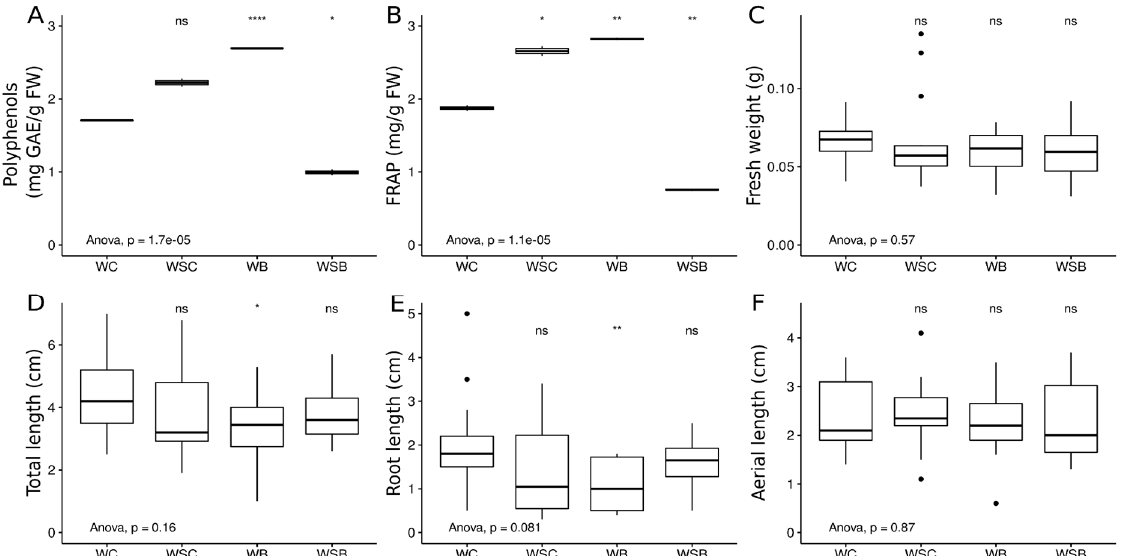
Figure 5. Boxplot representation of germination results of ( A ) polyphenols, ( B ) FRAP, ( C ) fresh weight, ( D ) total weight, ( E ) root length, and ( F ) aerial part length in each of the treatment groups (WC, without inoculum and no sucrose addition; WSC, without inoculum and sucrose addition; WB, with inoculum and no sucrose addition; WSB, with inoculum and sucrose addition). Results of the ANOVA comparison ( p -value) between treatments is reported as notation below the boxplot. Results of statistical comparison, using t -test, of each treatment group with respect to the control (WC treatment) are reported as annotations above each boxplot (ns: not significant; * p < 0.05; ** p < 0.01; **** p < 0.0001).